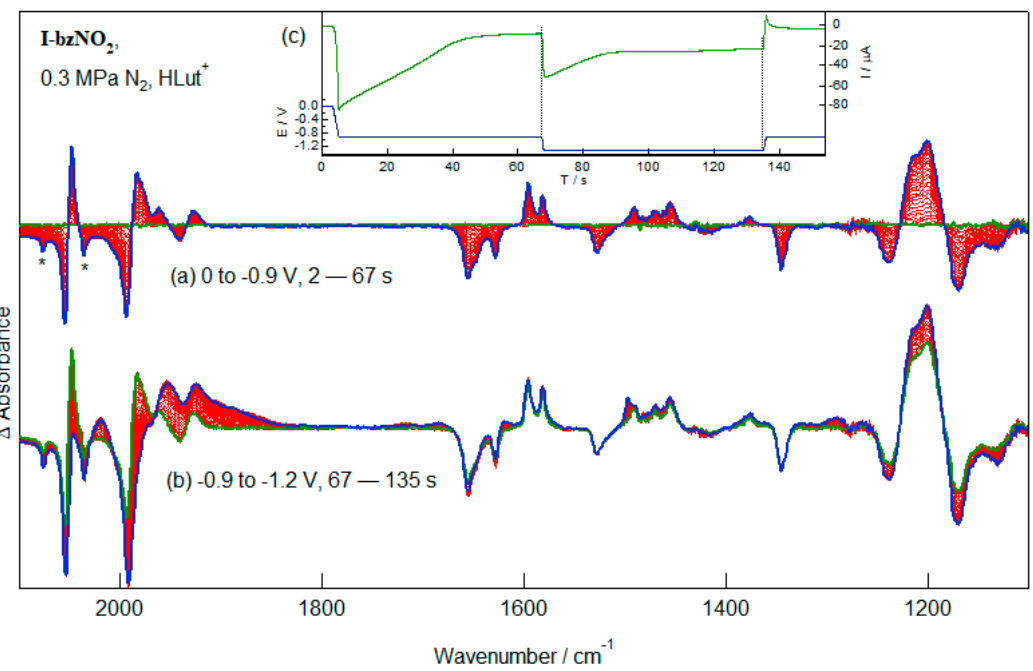
Figure 9. IR-SEC spectra recorded during the reduction of I-bzNO 2 in the presence of HLut + at (a) − 0.9 V and (b) − 1.3 V. Weak ν (CO) depletion bands (denoted by an asterisk) are due a small concentration of the hexacarbonyl species. Re-oxidation at 0 V after the initial reduction at − 0.9 V does not lead to any significant spectral changes (Figure S5).